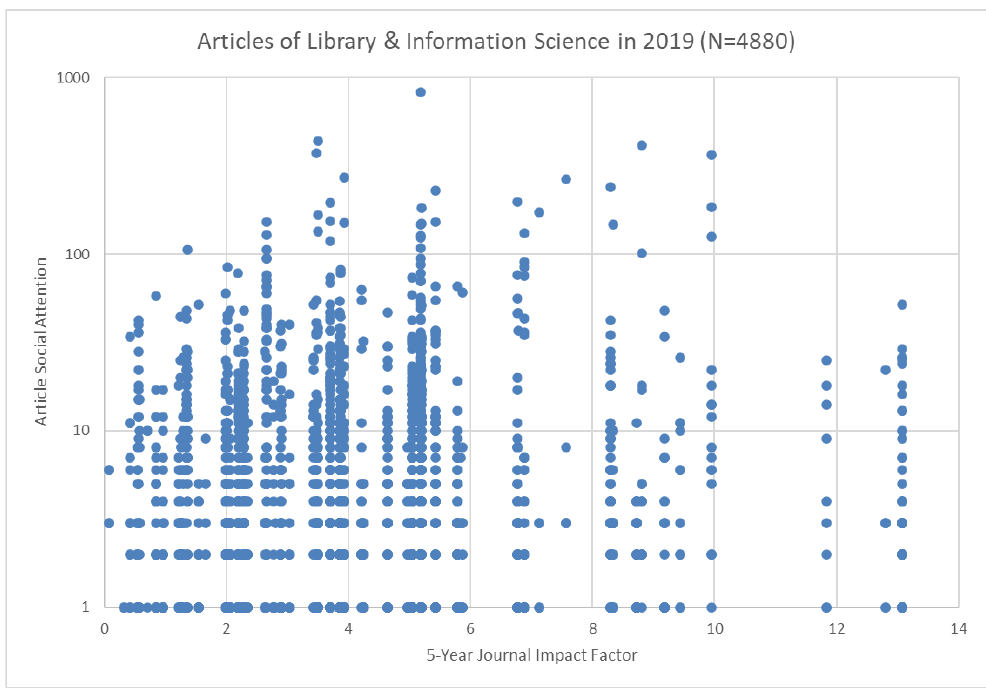
Figure 2. Social attention (logarithmic scale) of articles published in 2019, as a function of the journal’s 5-year impact factor (2020 edition), in the Library and Information Science category. A box-and-whisker plot by quartile for the 5-year journal impact factor (2020 edition) and the journal social attention (2021 edition) is shown in Figure 1. The differences between the groups are all significant for the journal social attention ( p < 0.01), except between